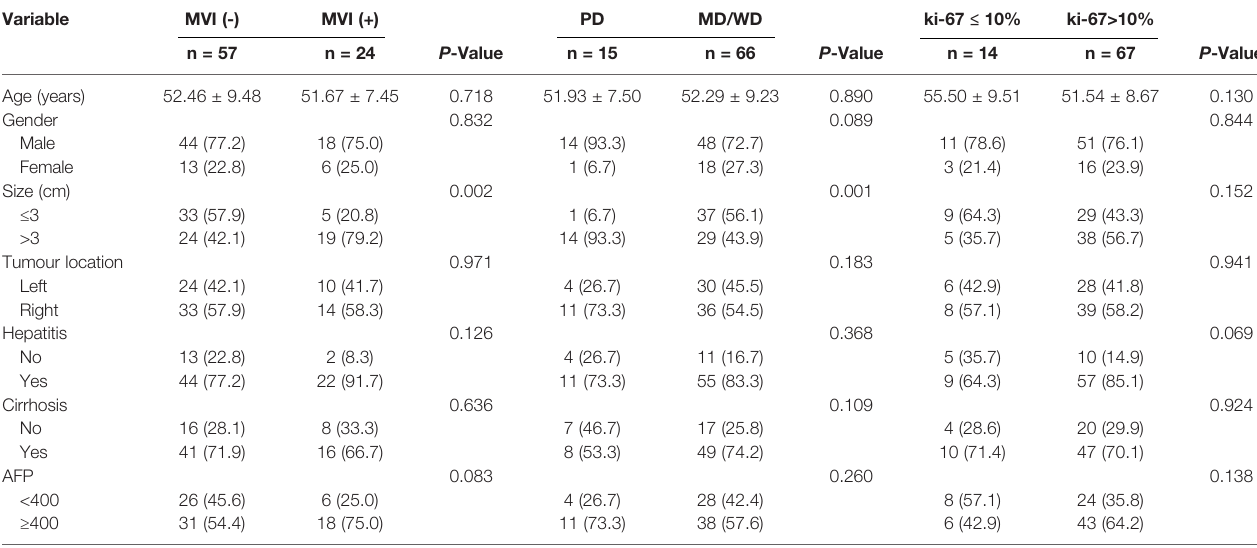
TABLE 1 | Clinical and pathological features of hepatocellular carcinoma. Variable